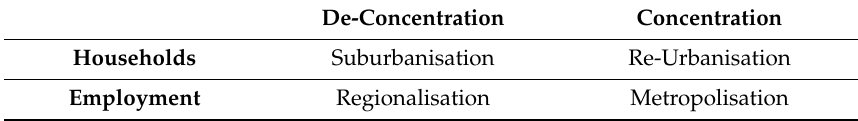
Table 1. Dynamics of concentration and de-concentration of households and